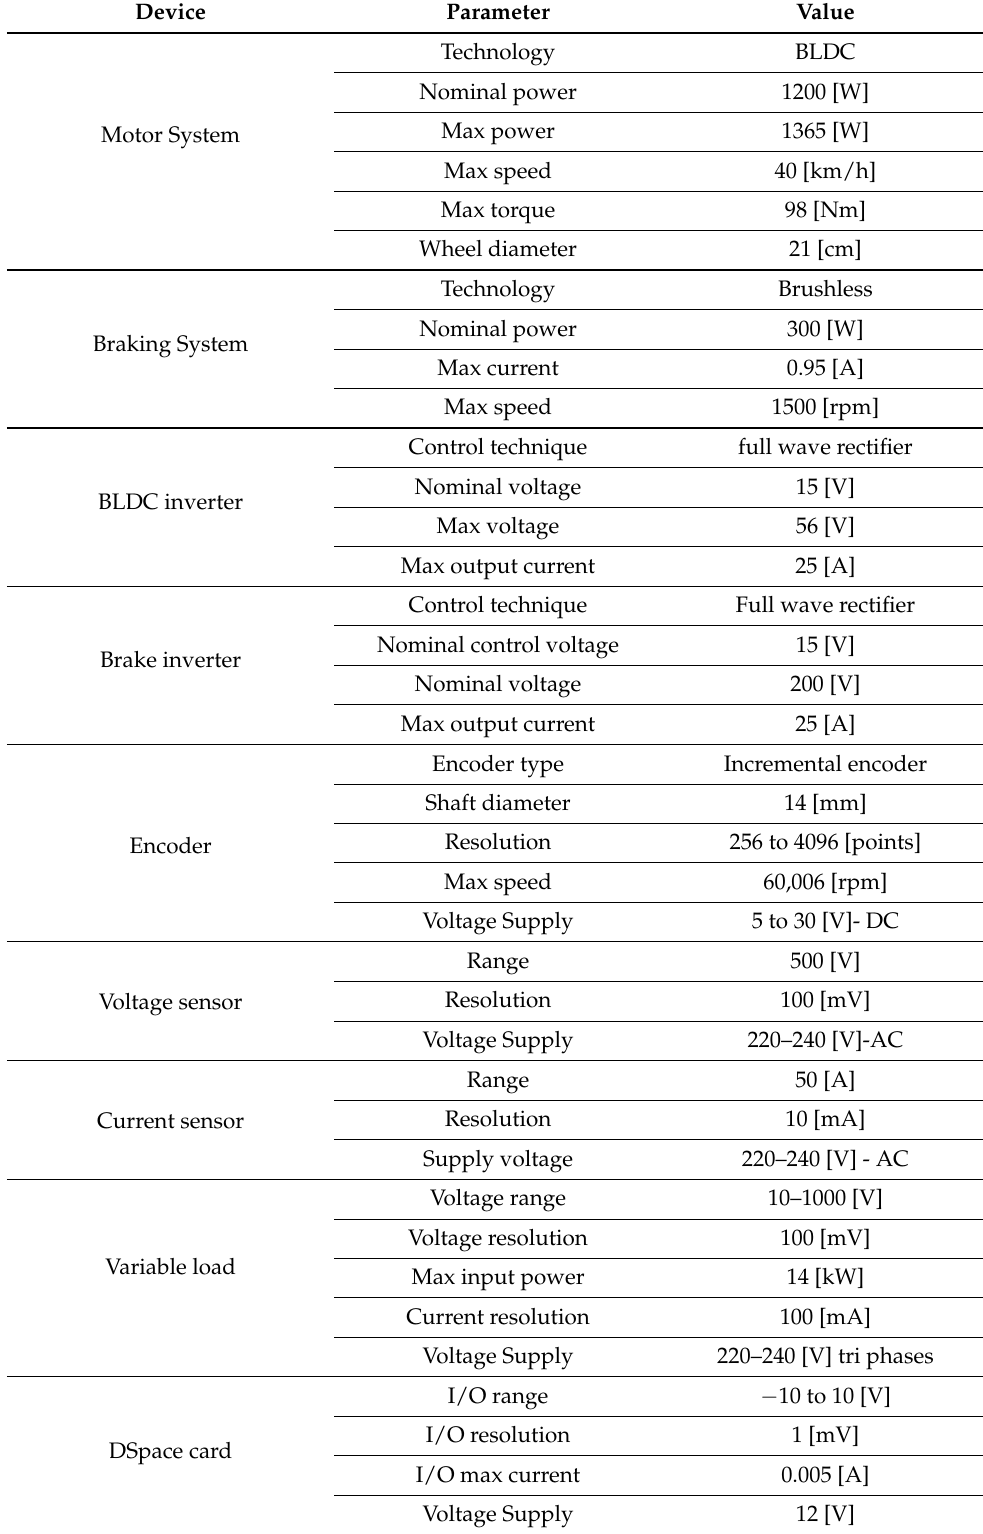
Table 1. Parameters related to Test bed